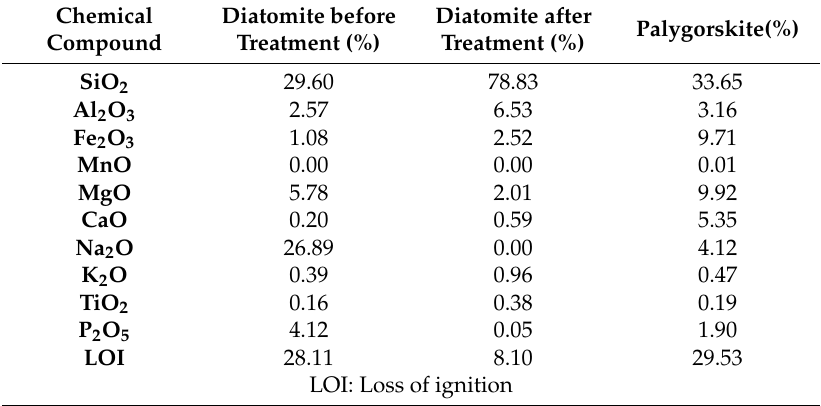
Table 1. Composition of natural diatomite (before and after treatment) and palygorskite. Chemical Diatomite before Diatomite after Compound Treatment (%) Treatment (%)